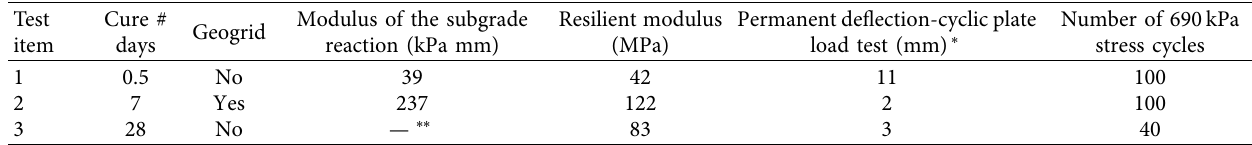
Figure 8: Static plate load test results of test item 1 and item 2. (a) Test item 1: 200mm of HFA. (b) Test item 2: 200mm of HFA stabilized with the geogrid (7-day Table 3: In situ resilient modulus and modulus of the subgrade reaction for HFA C-stone.